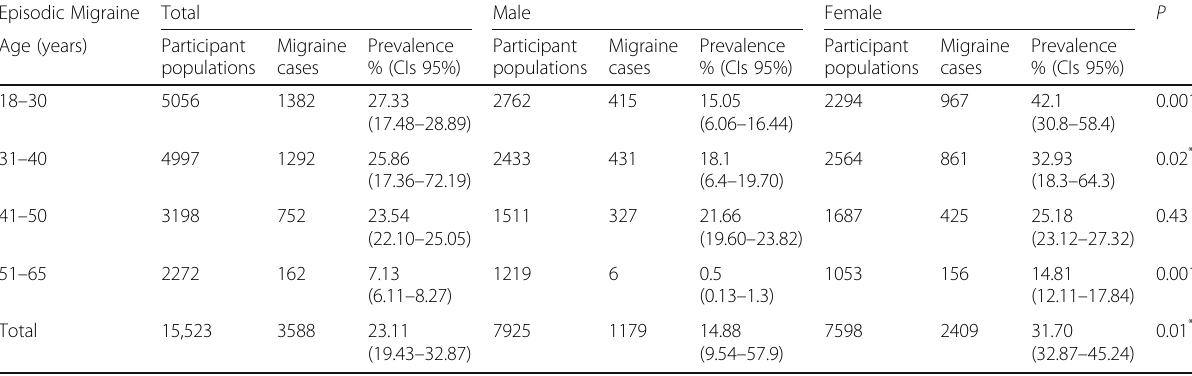
Table 1 One-year prevalence of Episodic Migraine Headache stratified by age and gender Episodic Migraine